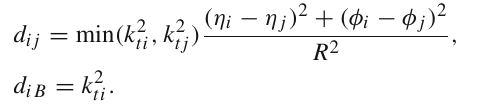
√ Table 1 Dijet cross sections at HERA with s = 314 GeV in the two (cid:4) E (cid:5) T 2 -bins defined in the text and the corresponding HERA data from the Table 7 in H1 collaboration